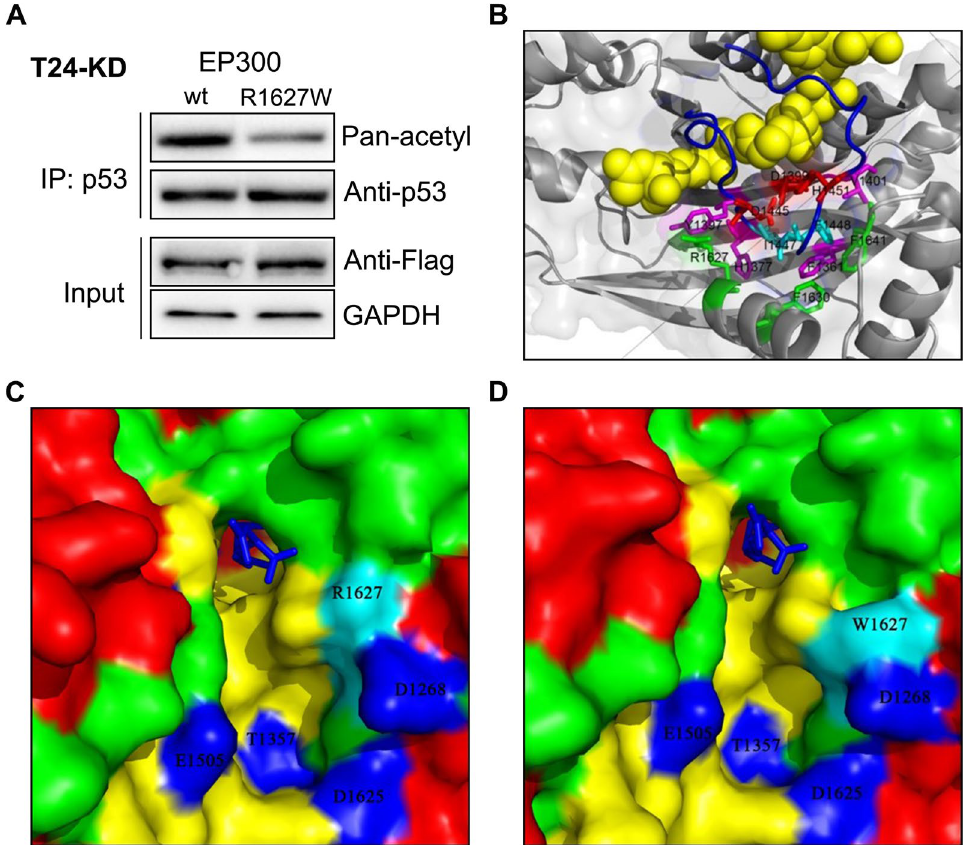
Fig. 5 R1627W mutation impairs EP300 HAT activity by disrupting substrate-binding capacity. A Lower level of TP53 acetylation are found in cells expressing EP300-R1627W than those expressing EP300-wt. TP53 was first immunoprecipitated, and then TP53 acetylation was assessed using pan-lysine acetylation antibody. B R1627 positions in close to, but not direct contact with, the HAT catalytic core of EP300. A long loop (blue), together with its hydrogen-bonding interaction (red sticks) and hydrophobic interaction (pink sticks) amino acids, forms the catalytic core that embraces the substrate (yellow sphere). C , D Protein surface views of EP300-wt (left) and EP300-R1627W (right) catalytic core, which were analyzed and rendered using Pymol software. The side chain of T1357, E1505, D1625 and D1627 (blue) form a negative potential of a pocket for polypeptide substrate binding. R1627/W1627 is intimate facing this pocket. Side chain resulted from R > W substitution could greatly disrupt the electrostatic property of the